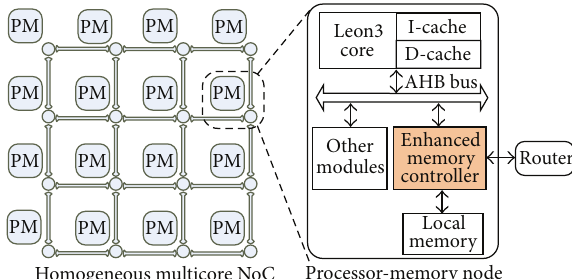
Figure 8: The homogenous OLPC experimental